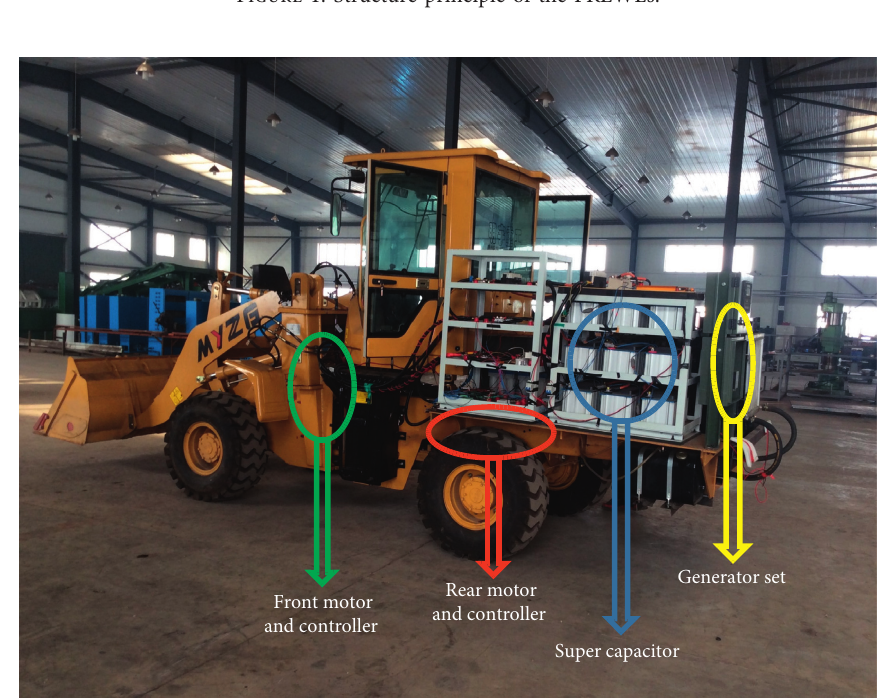
Figure 2: Experimental prototype of FREWLs.